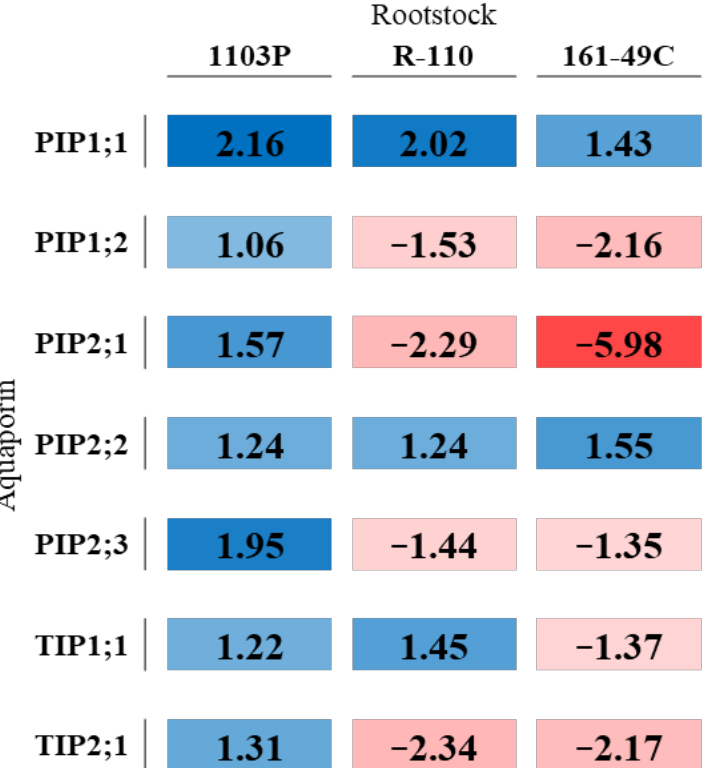
Figure 2. Aquaporin gene expression in each rootstock. Values represent the difference between well water (WW) and water stress (WS) expressions. A color gradient from blue (up-regulated) to red (down-regulated) shows the gene expression in each condition.